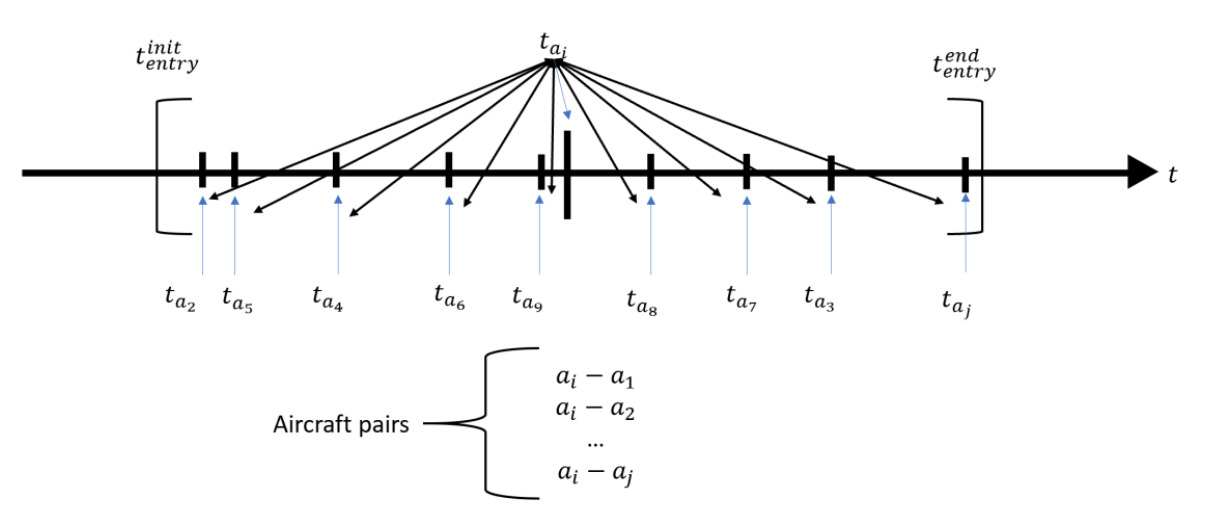
Figure 4. Generation of the aircraft pairs with temporary modifications.